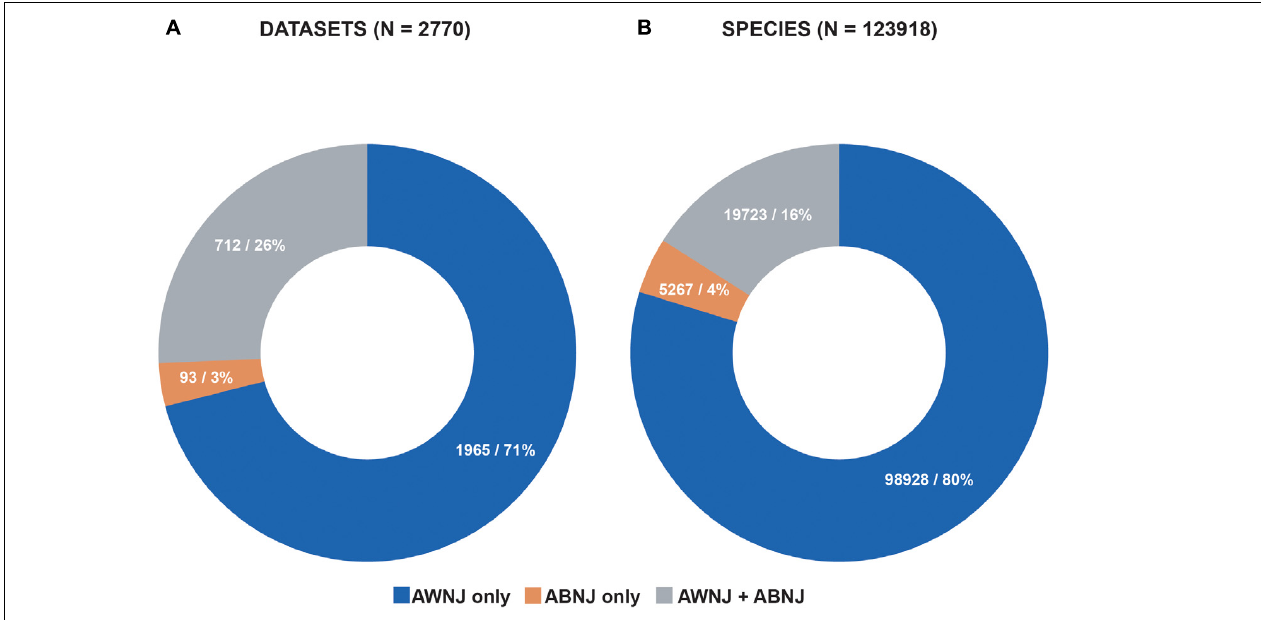
FIGURE 2 | (A) 3% of the datasets in OBIS only hold data from ABNJ and 26% of the datasets hold data from both AWNJ and ABNJ, 71% of the datasets in OBIS hold data from AWNJ. (B) 4% or more than 5000 species occur exclusively in ABNJ, 16% occur in both AWNJ and ABNJ, and 80% occur only in AWNJ. Source: OBIS, 1 February